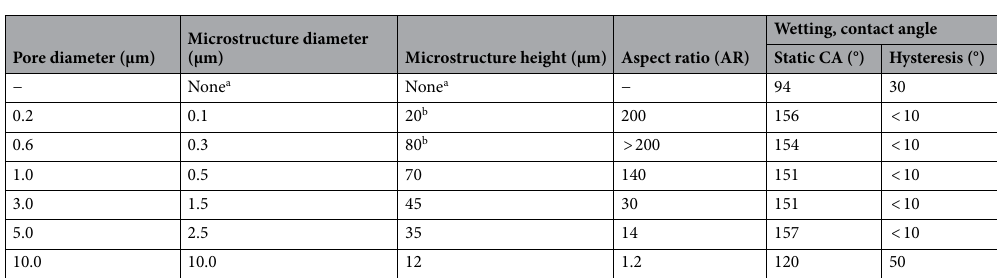
Table 1. Aspect details of the various ion-track etched polycarbonate membranes employed as templates as well as of the resulting HDPE microstructured films and their corresponding wetting behavior. a HDPE film as received. b approximated